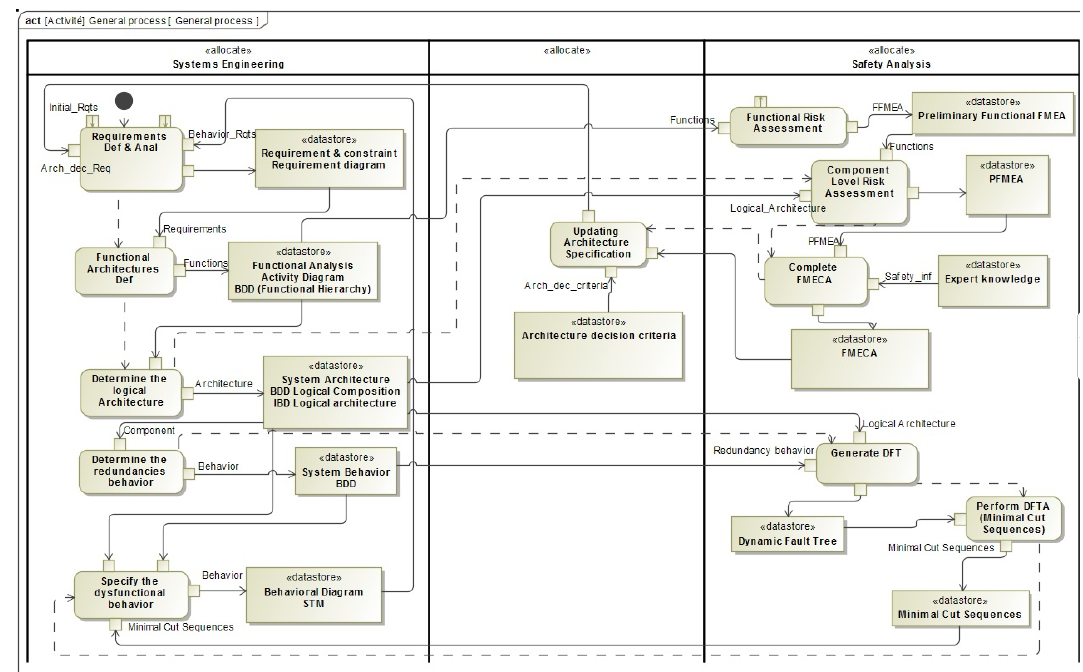
Figure 2. Detailed process of the general